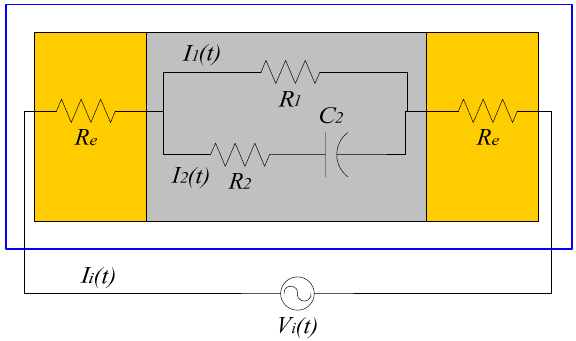
Figure 2. The equivalent electrical circuit for an IPMC